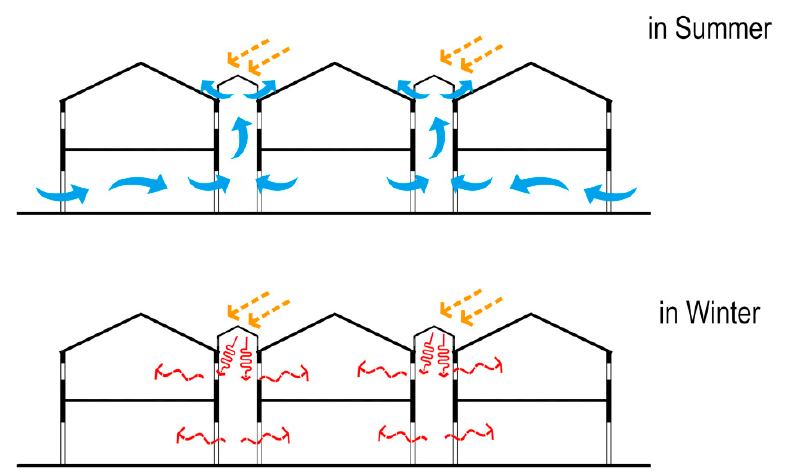
Figure 12. Working diagram of using solar energy and a sunroom in summer and winter.